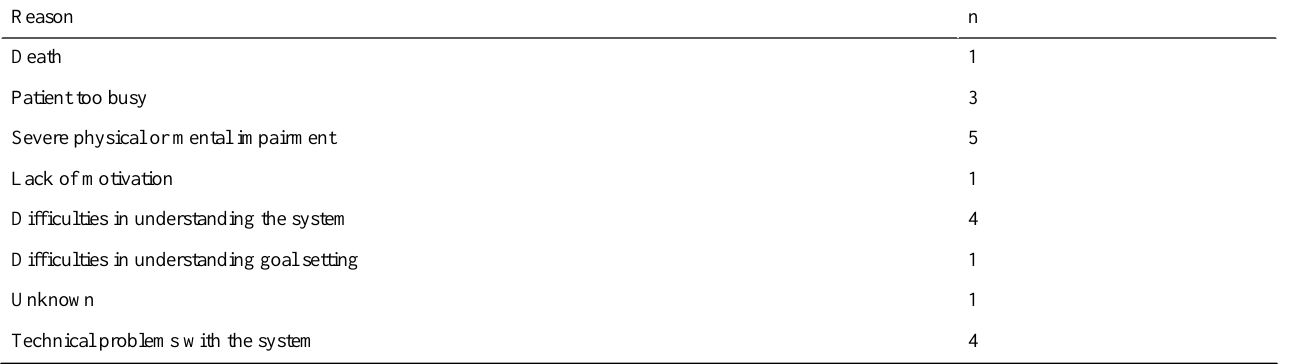
Table 6. Reasons for not starting coaching